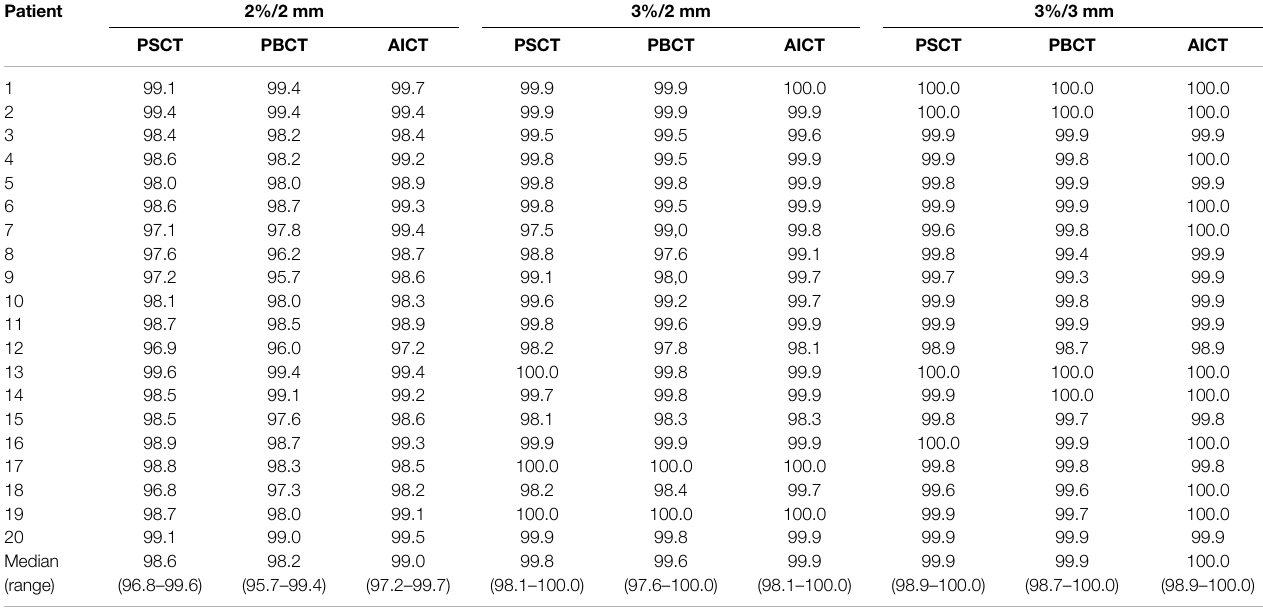
TABLE 3 | Comparison of percentage pass rates for PSCT, PBCT, and AICT approaches using a 2 mm/2%, 2 mm/3%, and 3 mm/3% criterion, respectively, with a 40% lower dose threshold of the maximum dose. The bottom row depicts the median (range) pass rate over all patients.